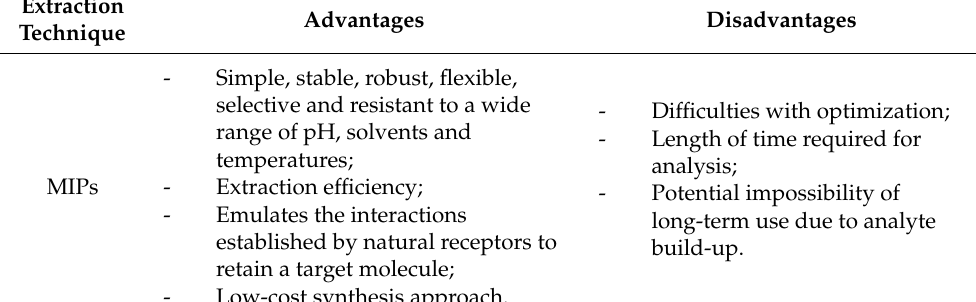
Table 9. Advantages and disadvantages of the MIPs and TFME procedures. Extraction Technique